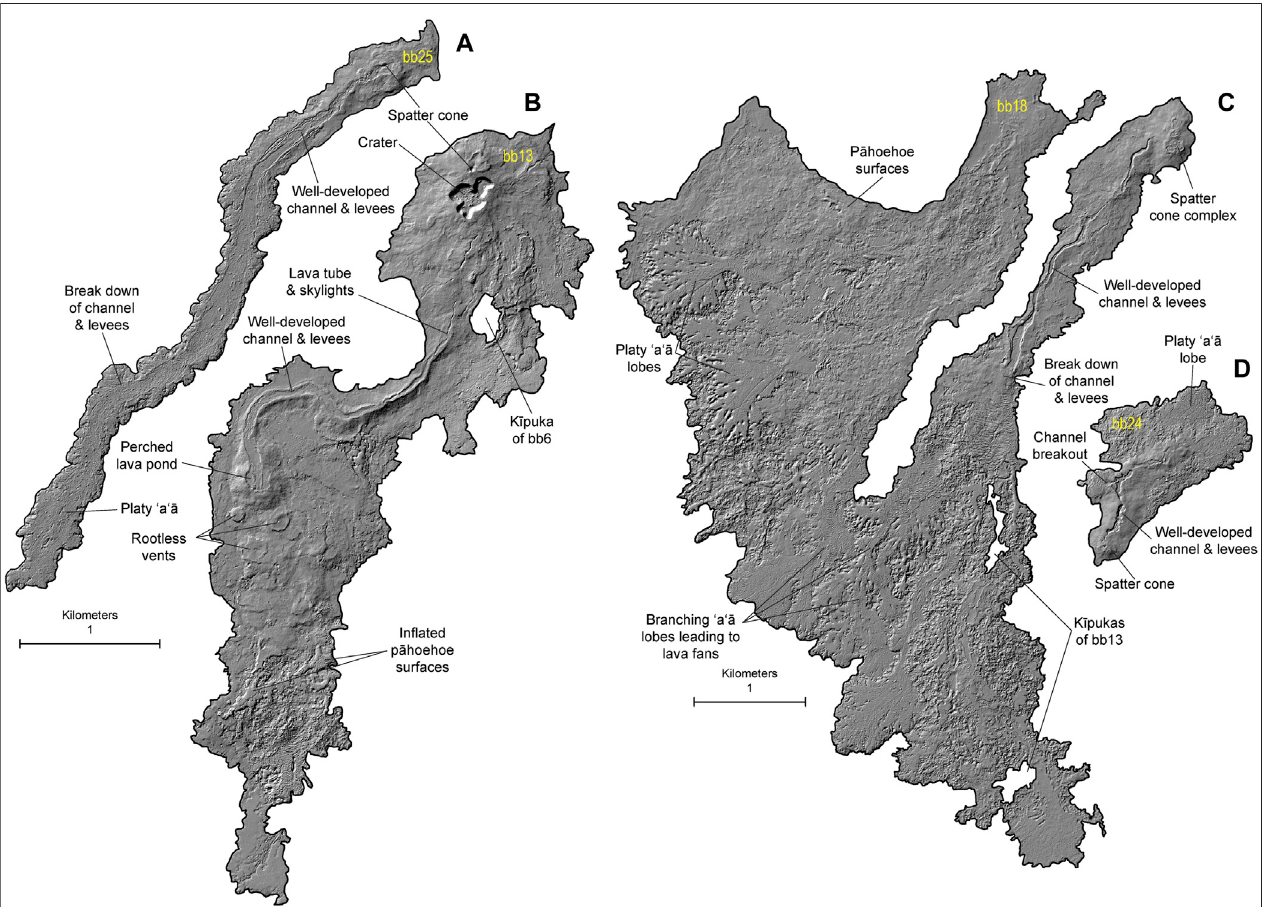
FIGURE 6 | 1 m-resolution lidar-derived hillshade showing the variety of volcanic landforms identi fi ed within the Brushy Butte fl ow fi eld from units (A) bb25 (B) bb13 (C) bb18, and (D) bb24. These fl ow morphologies include well-established channels and levees of rubbly and slabby p (cid:1) ahoehoe and platy ʻ a ʻ (cid:1) a, breakouts through or over the top of levees, lava ponds, in fl ated p (cid:1) ahoehoe surfaces, spatter cones, and craters.